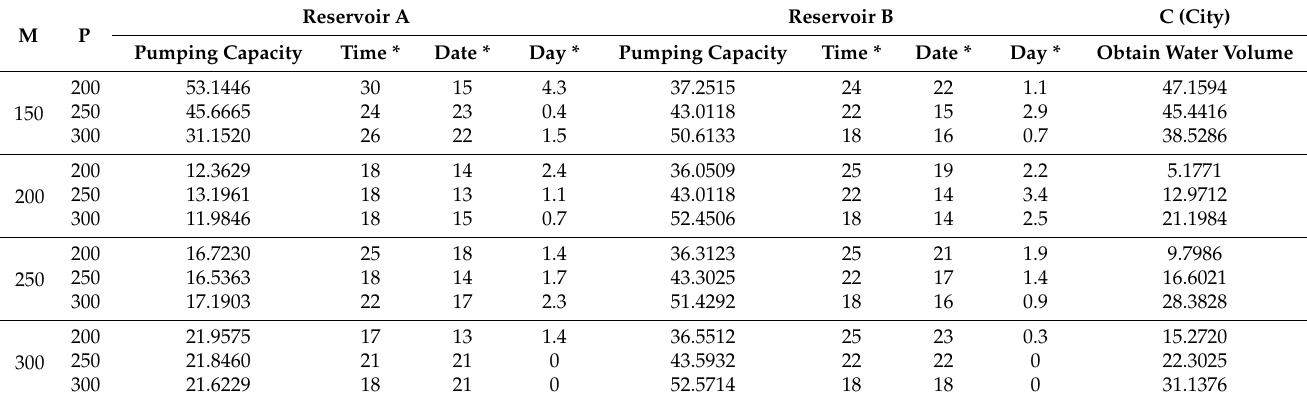
Table 2. Comparison of water level combination data when meeting water and electricity demand.